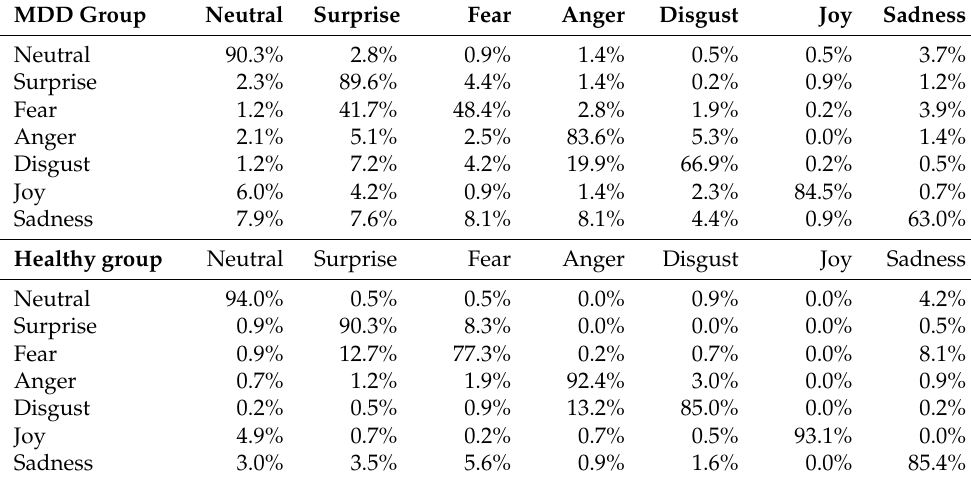
Table 2. Emotion recognition scores for each emotion depicted for the depression group and healthy controls.